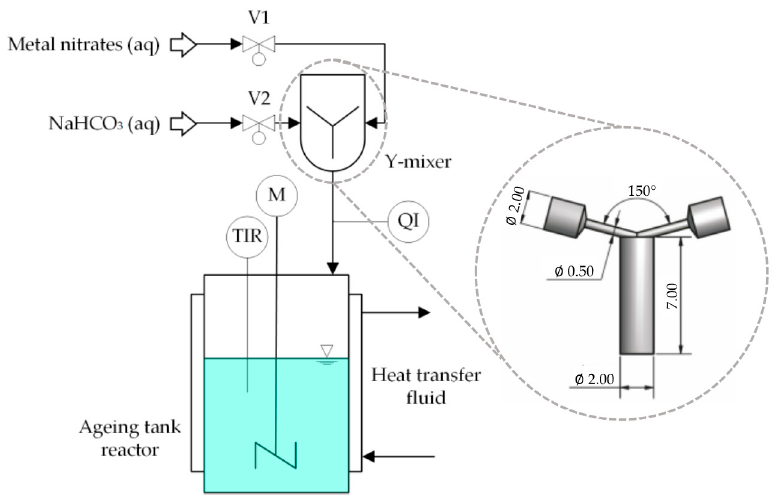
Figure 7. Schematic set ‐ up of the continuous co ‐ precipitation (TIR—temperature display and registration, M—motor, QI—pH display) and the dimension of the Y ‐ mixer in mm adapted from [53]. registration, M—motor, QI—pH display) and the dimension of the Y-mixer in mm adapted from